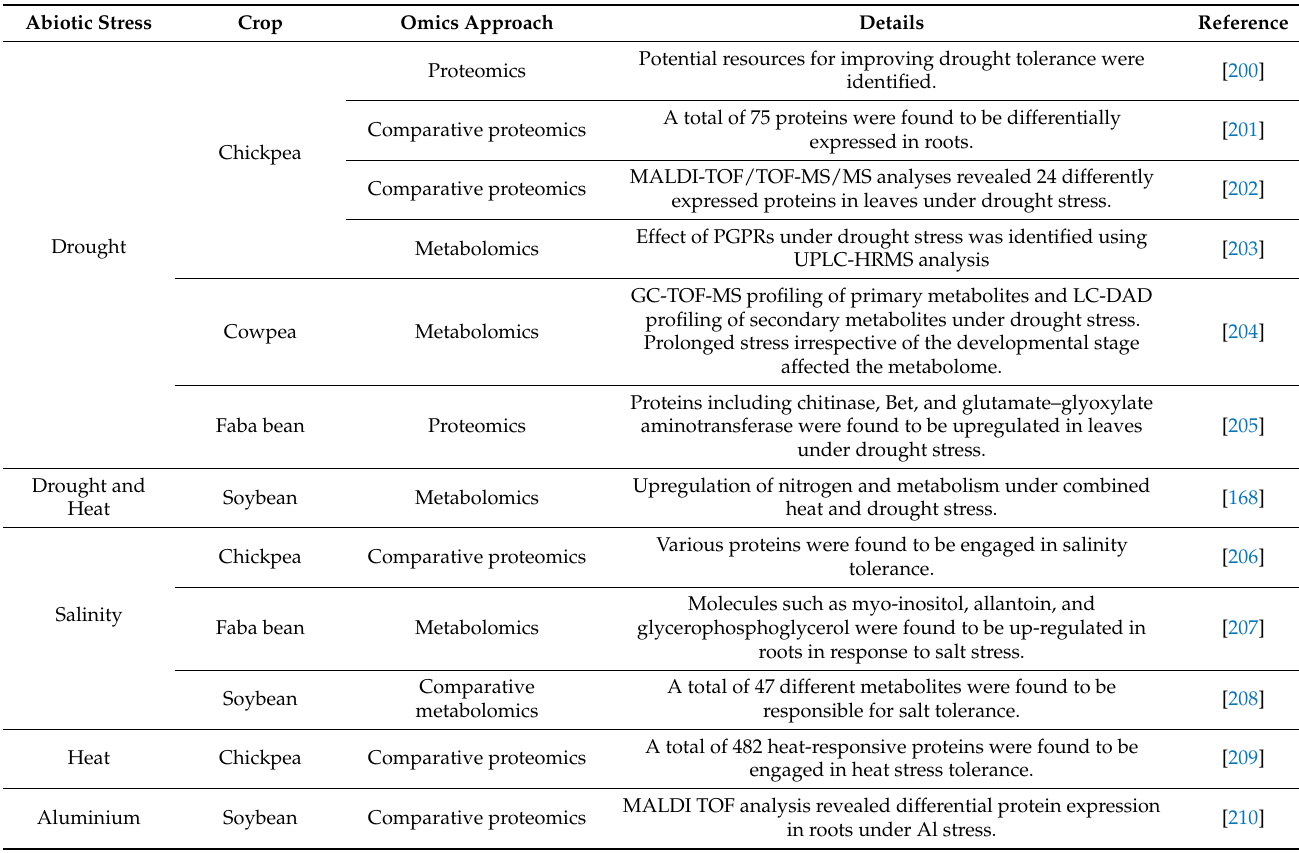
Table 7. Application of proteomics and metabolomics in abiotic stress mitigation in pulse crops. Abiotic